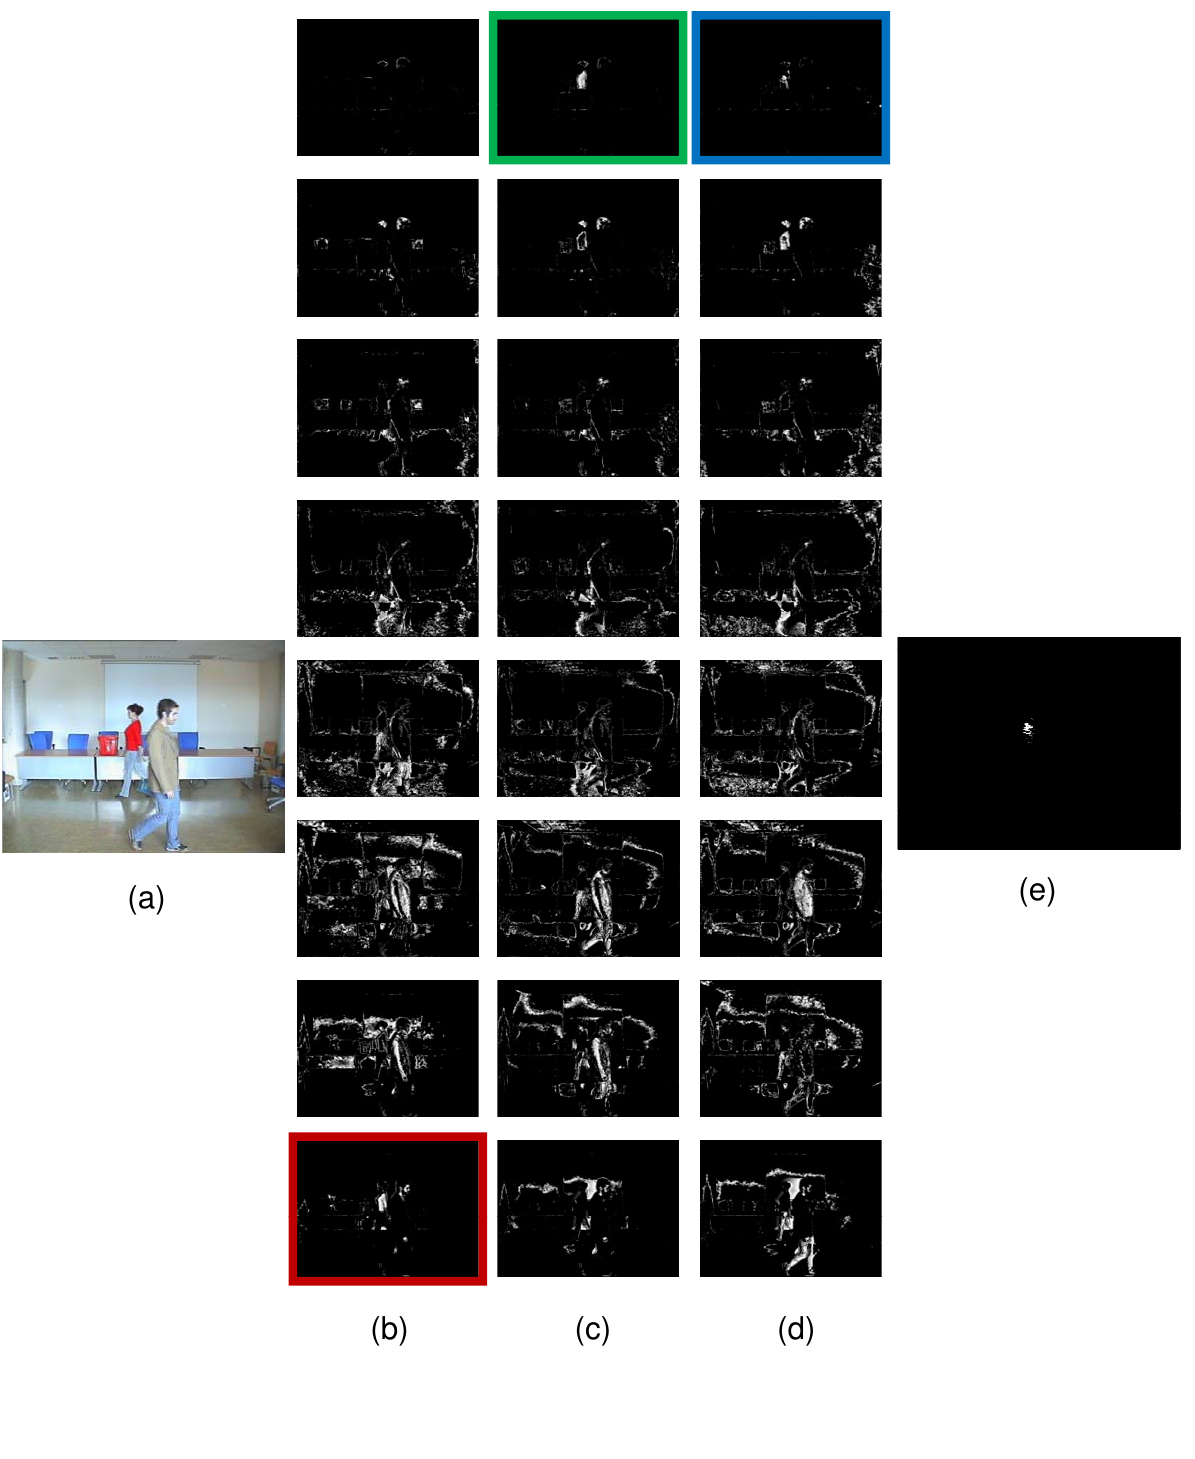
Figure 8. Result of AC detection modules for color-based people tracking. (a) Input image. From top to bottom, bands 0 to 7 , result of AC on the (b) R component, (c) G component, (d) B component. (e) Result of tracking the red